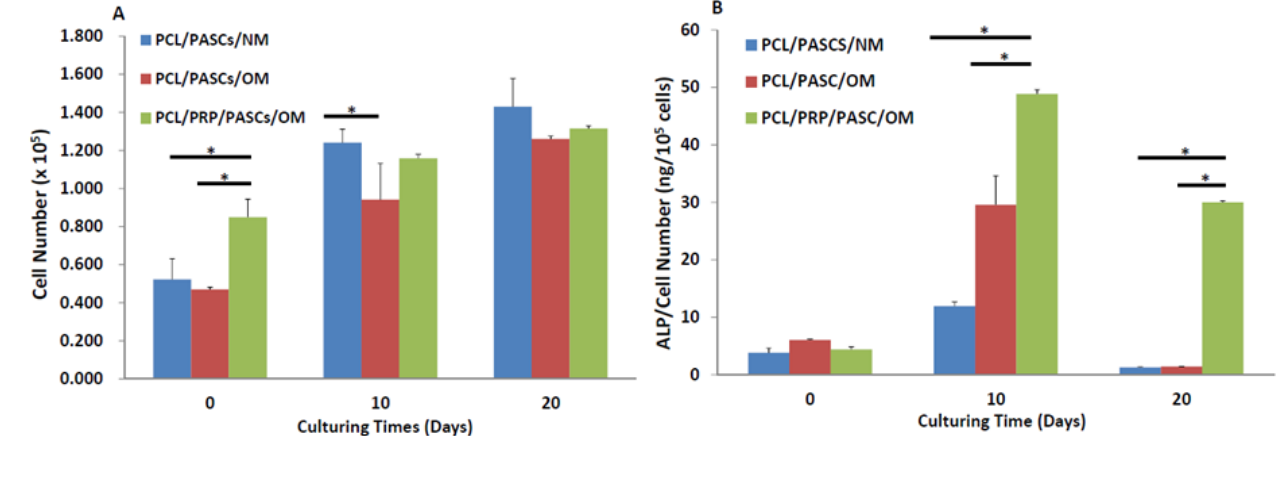
Figure 2. Comparison of ( A ) cell proliferation and ( B ) alkaline phosphatase (ALP) secretion of porcine adipose-derived stem cells (PASCs) in PCL and PCL/PRP scaffolds at different time points. NM, normal medium; OM, osteogenic medium. * p <